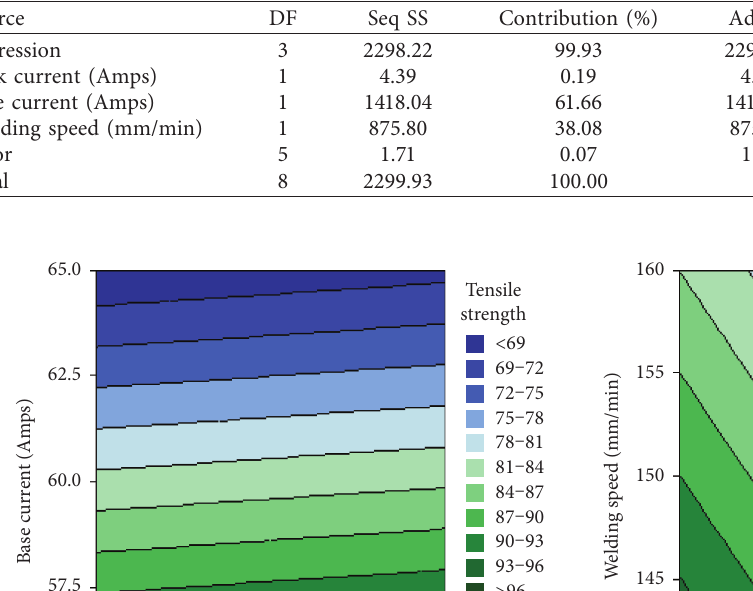
Figure 7: Main effect plot for S/N ratios. Table 10: Analysis of variance for the regression model (S/N ratio-tensile strength).